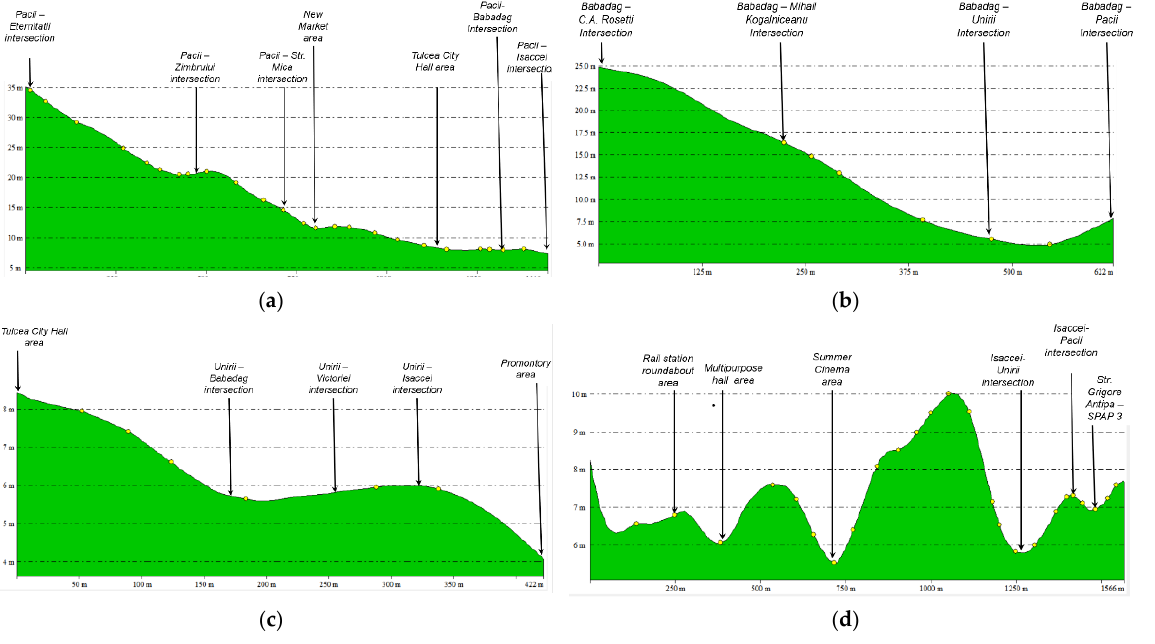
Figure 7. Longitudinal profile along: ( a ) Pacii street; ( b ) Babadag street; ( c ) Unirii street; and ( d ) Isaccea street.